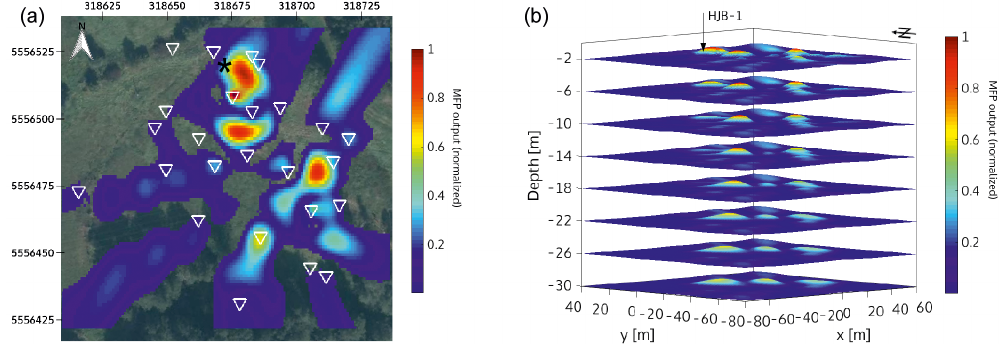
Figure 6. matched field processing (MFP) results (normalized) for the array deployed in May 2015 in the Hartouˆsov mofette field. (a) Surface plot. The white triangles indicate the position of stations. The black star shows the location of HJB-1. (b) 3-D depth plot